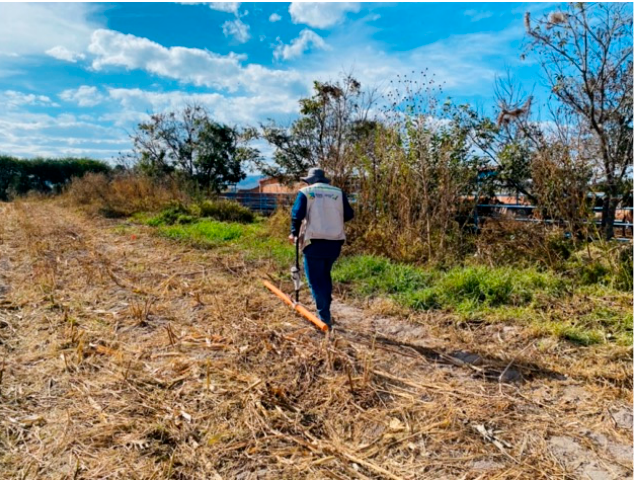
Figure 3. Electrical conductivity survey using the EMP meter on route or on profile.